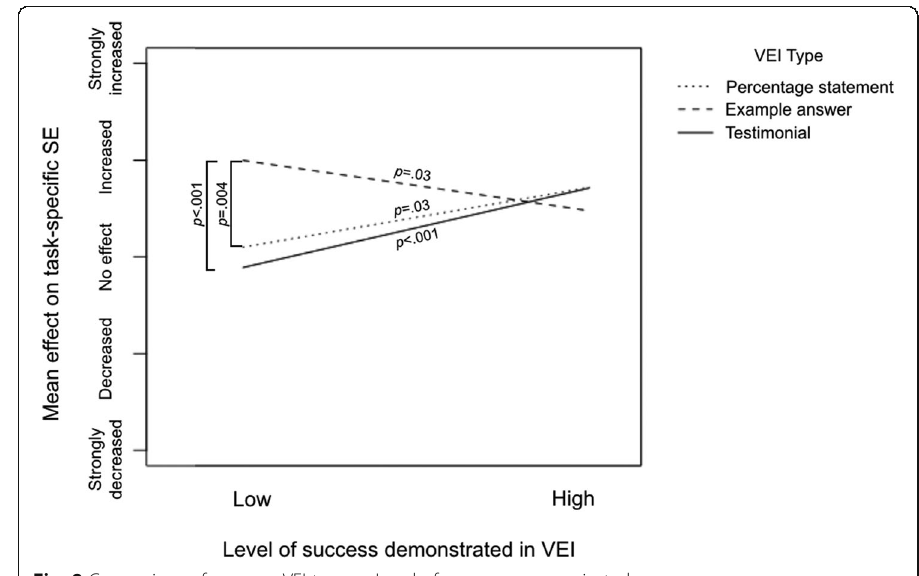
Fig. 8 Comparison of means - VEI type vs Level of success communicated